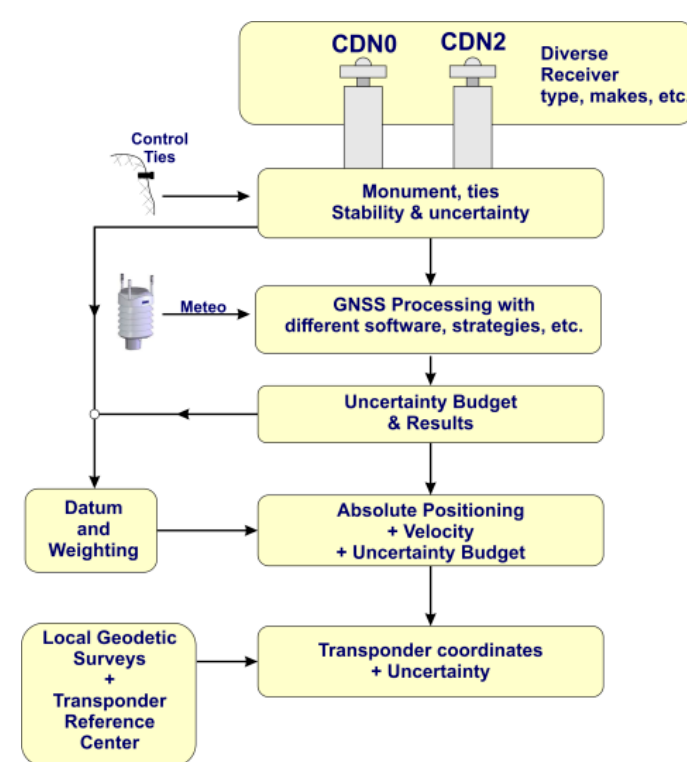
Figure 18. An example of data processing and procedures, in a Block diagram, to arrive at the transponder absolute coordinates and their uncertainties.